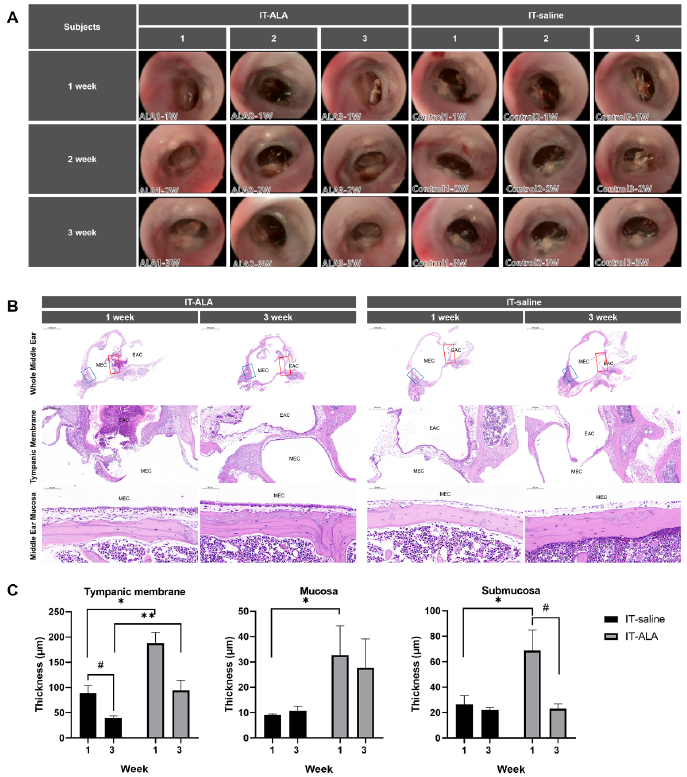
Figure 2. Assessment of the middle ear safety. ( A ) The otoendoscopic findings of the tympanic membrane showed no significant differences between the IT-saline and IT-ALA groups. Representative light microscopic findings ( B ) and thickness analysis of the tympanic membrane, mucosal, and submucosal layers ( C ). A significant increase in the thickness of middle ear mucosa was observed in the IT-ALA group 1 week after injection ( p < 0.05); however, the difference in mucosa and submucosa thickness between IT-ALA and IT-saline groups decreased 3 weeks after injection except for the tympanic membrane thickness ( p = 0.01). IT, intratympanic; ALA, α -lipoic acid; DEX, dexamethasone. The red square indicates the tympanic membrane, and the blue square indicates middle ear mucosa posterior to the Eustachian tube. Mann–Whitney test for inter-group comparison, * p < 0.05, ** p < 0.01, Mann–Whitney test for within-group comparison, # < 0.05.